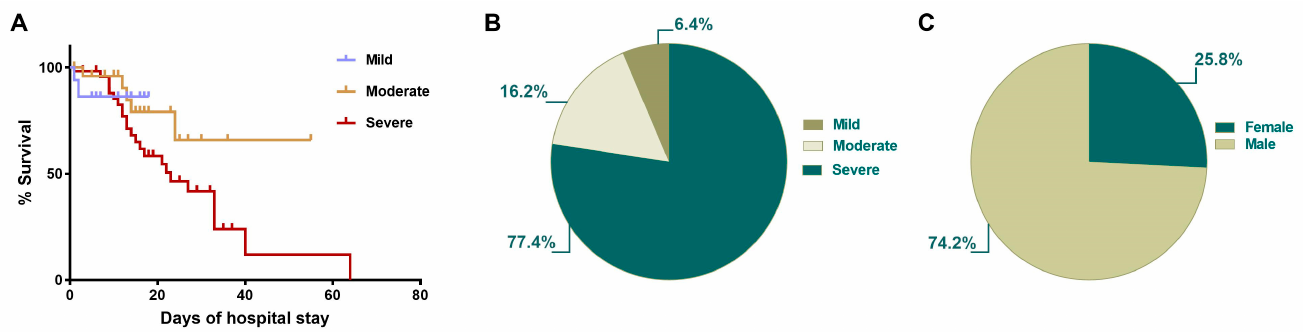
Figure 1. Survival of patients with SARS-CoV-2 infection decreased according to illness severity and hospital stay. ( A ) Kaplan–Meier survival curve in COVID-19 patients. The severe condition group had a hospital stay of 1–64 days (mean of 14.9 days), patients with a moderate illness had a hospital stay between 1 and 55 days (mean of 14.2 days), and the mild group had a hospital stay between 1 and 18 days (mean of 7.9 days. ( B ) Total cohort mortality was 30.4%, with the severe group tallying 77.4%, while moderate group represented 16.2% and the mild group 6.4% of deaths. ( C ) The higher death rate occurred in the male population with a severe classification; 31 patients died: 23 (74.2%) were male, and 8 (25.8%) were